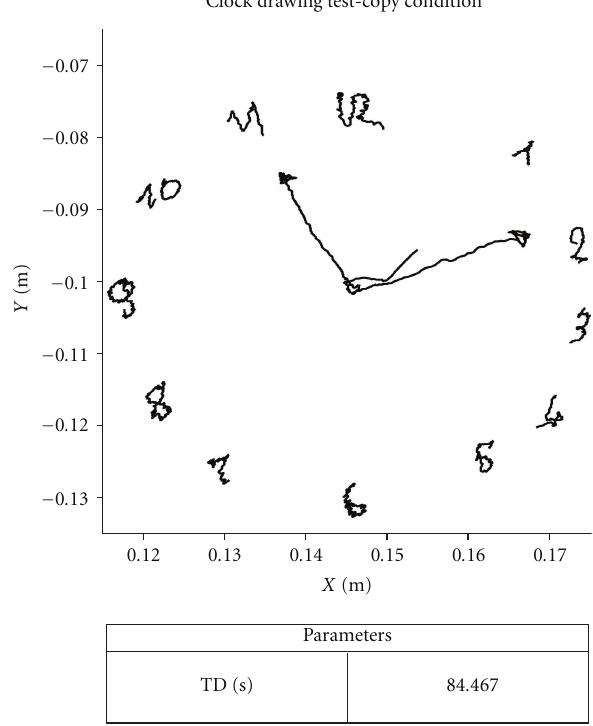
Figure 2: An example report of the Clock Drawing Test obtained with Smart Analyzer software, drawn by a CG subject.